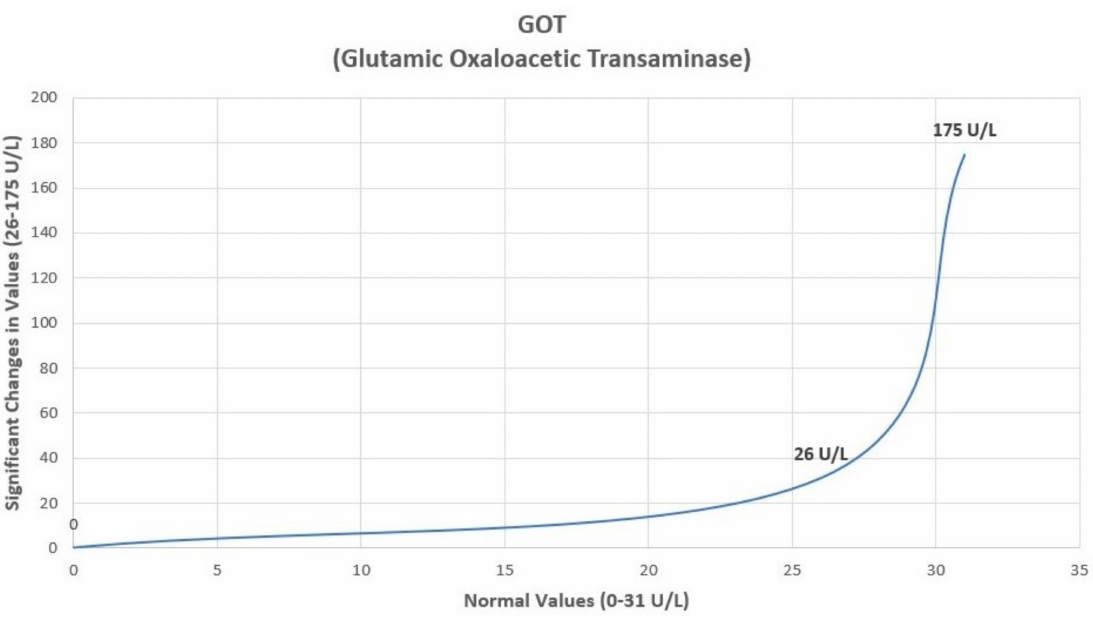
Figure 2. Significative changes in the